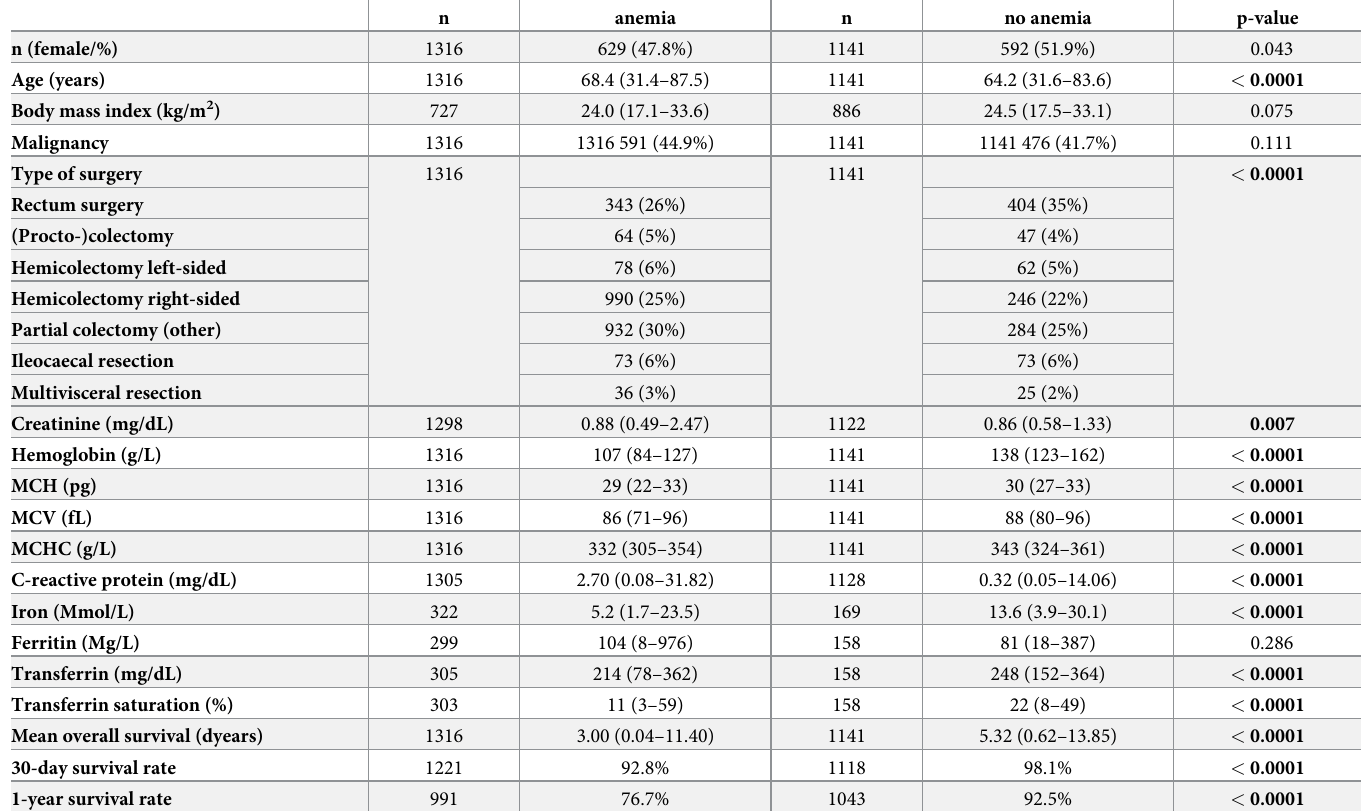
Table 1. Entire cohort anemia vs. no anemia. (Data are presented as numbers and percentages for frequencies and as mean ± standard deviation for normally distributed parameters and as median (25 th —75 th ) percentile for not normally distributed parameters).